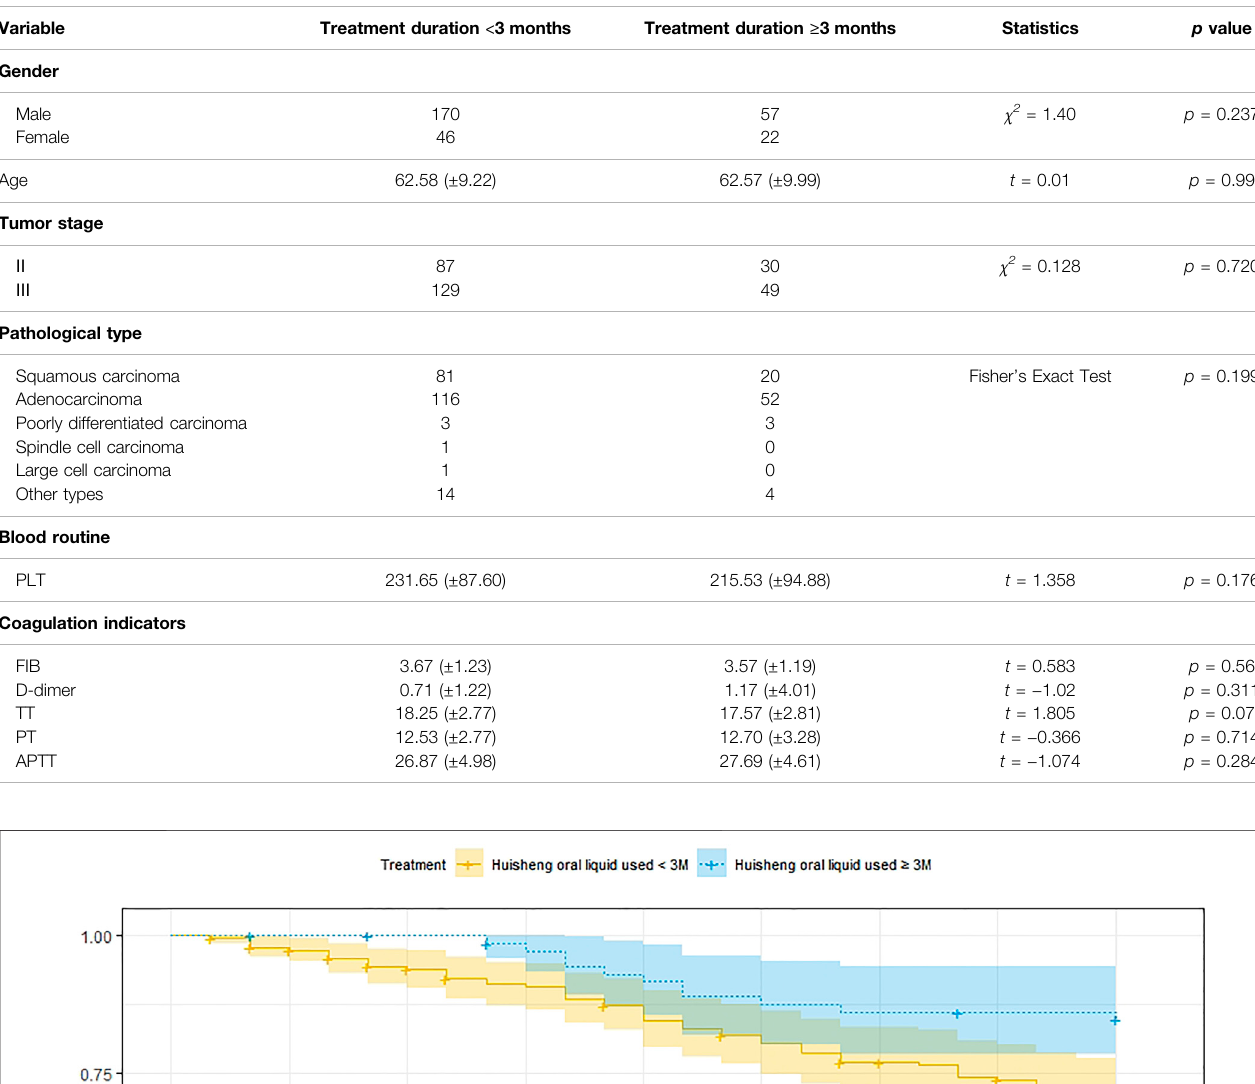
TABLE 4 | Baseline comparison between the HSOL use for < 3 months and ≥ 3 months group.